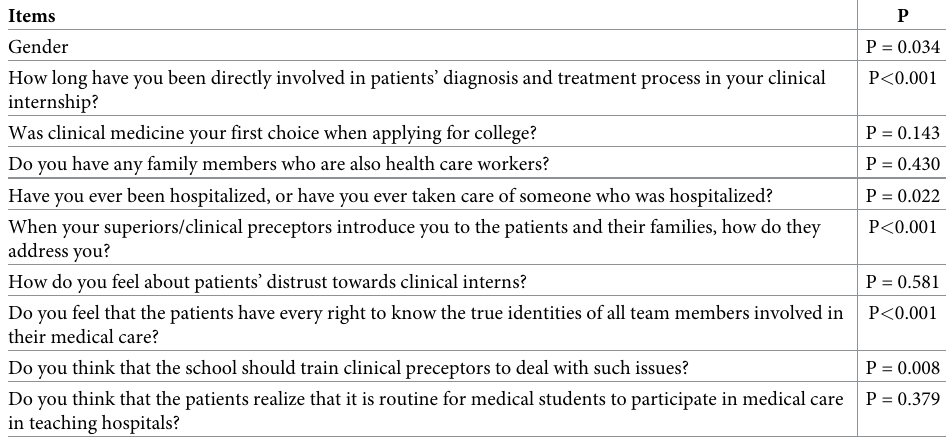
Table 3. Chi-square test of factors influencing how students introduce themselves to patients.